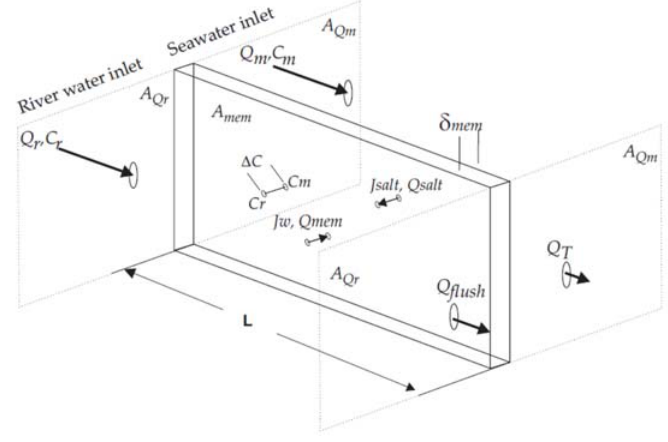
Figure 4. Membrane module sketch.